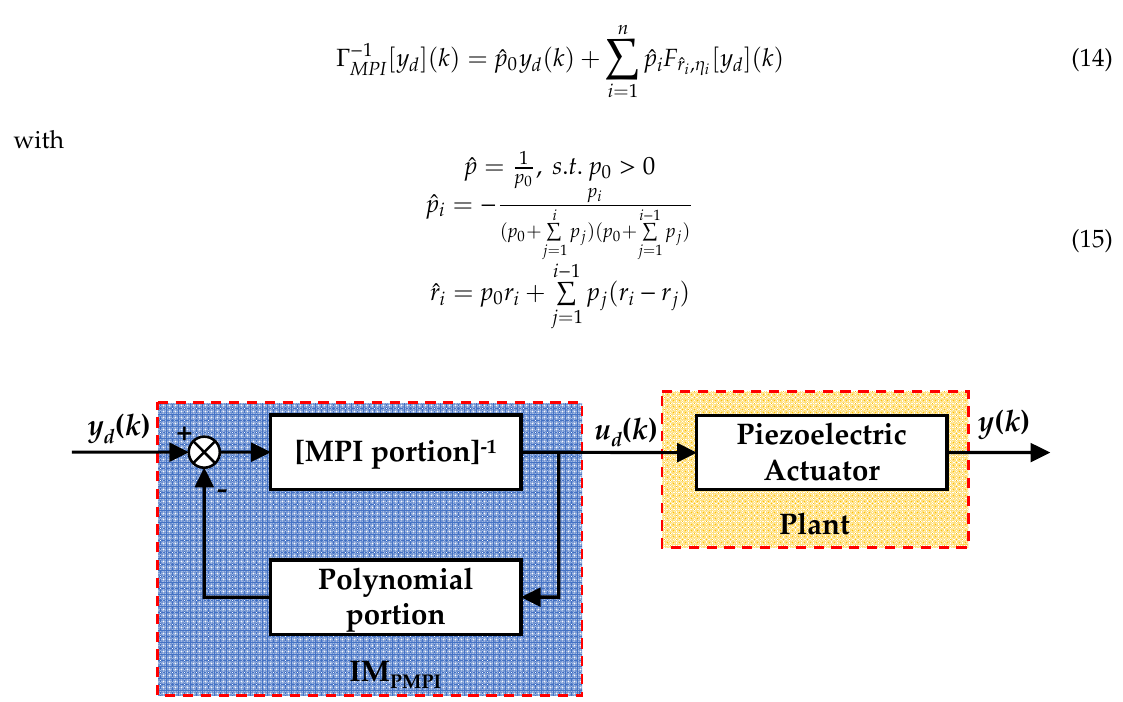
Figure 10. Schematic diagram of inverse model (I-M) compensator.